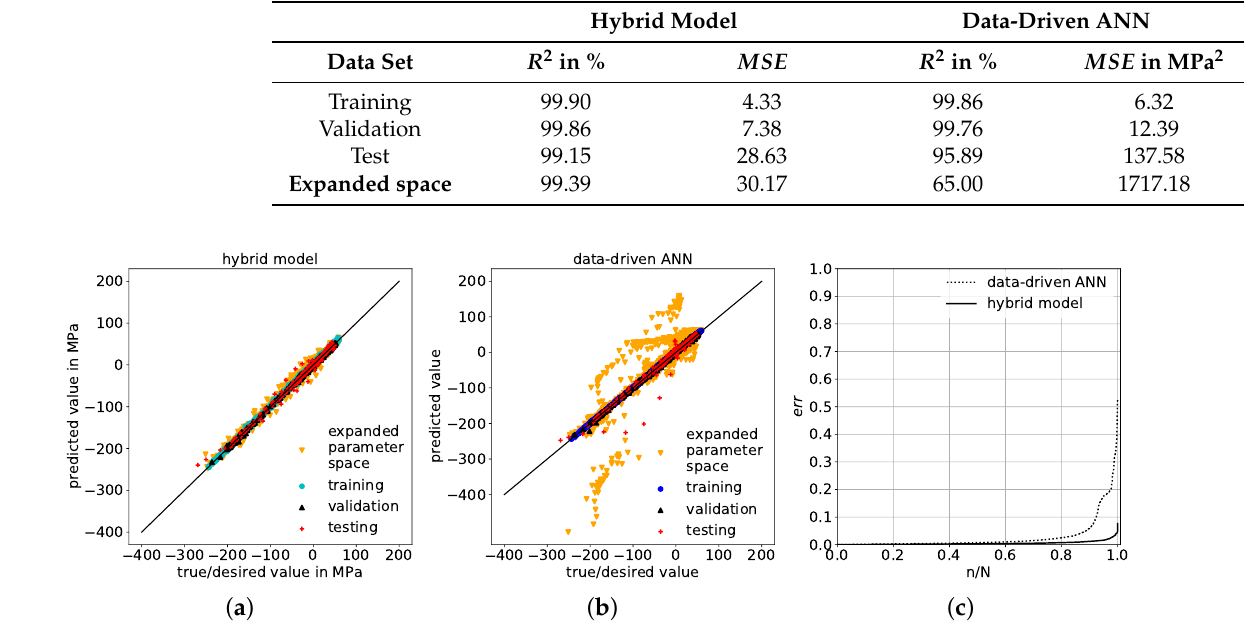
Figure 12. Juxtaposition of predicted values and true/desired values on training, validation, test sets and expanded parameter space data set, achieved by ( a ) the physics-based hybrid model and ( b ) the purely data-driven ANN, respectively. ( c ) shows the relative error of samples n normalized with the total number of samples N, sorted from low to high err values on the data set with expanded parameter space generated by hybrid model and data-driven